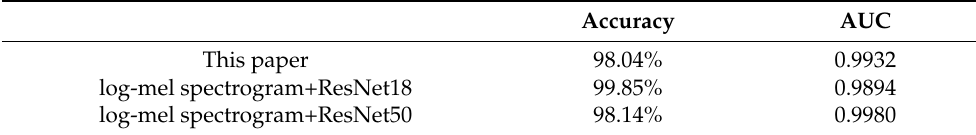
Table 7. Fixed-length segmentation experimental results.